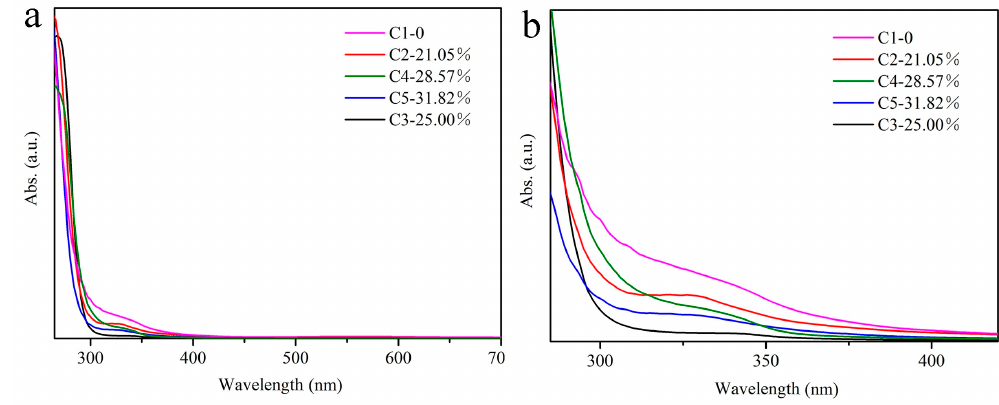
Figure 9. (a) The XRD patterns of Cs 2 SnCl 6 crystals doped with different concentration of Ce; ( b ) the zoom in view in the range of 34-35 o .